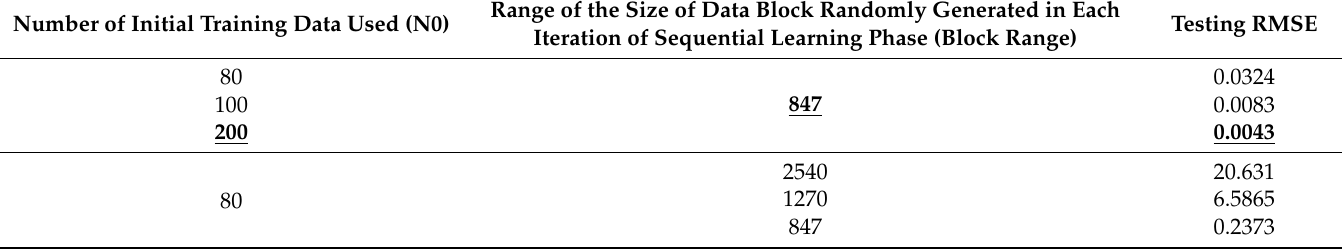
Table 11. Results of adaptive online sequential ELM with sinusoidal activation function using five